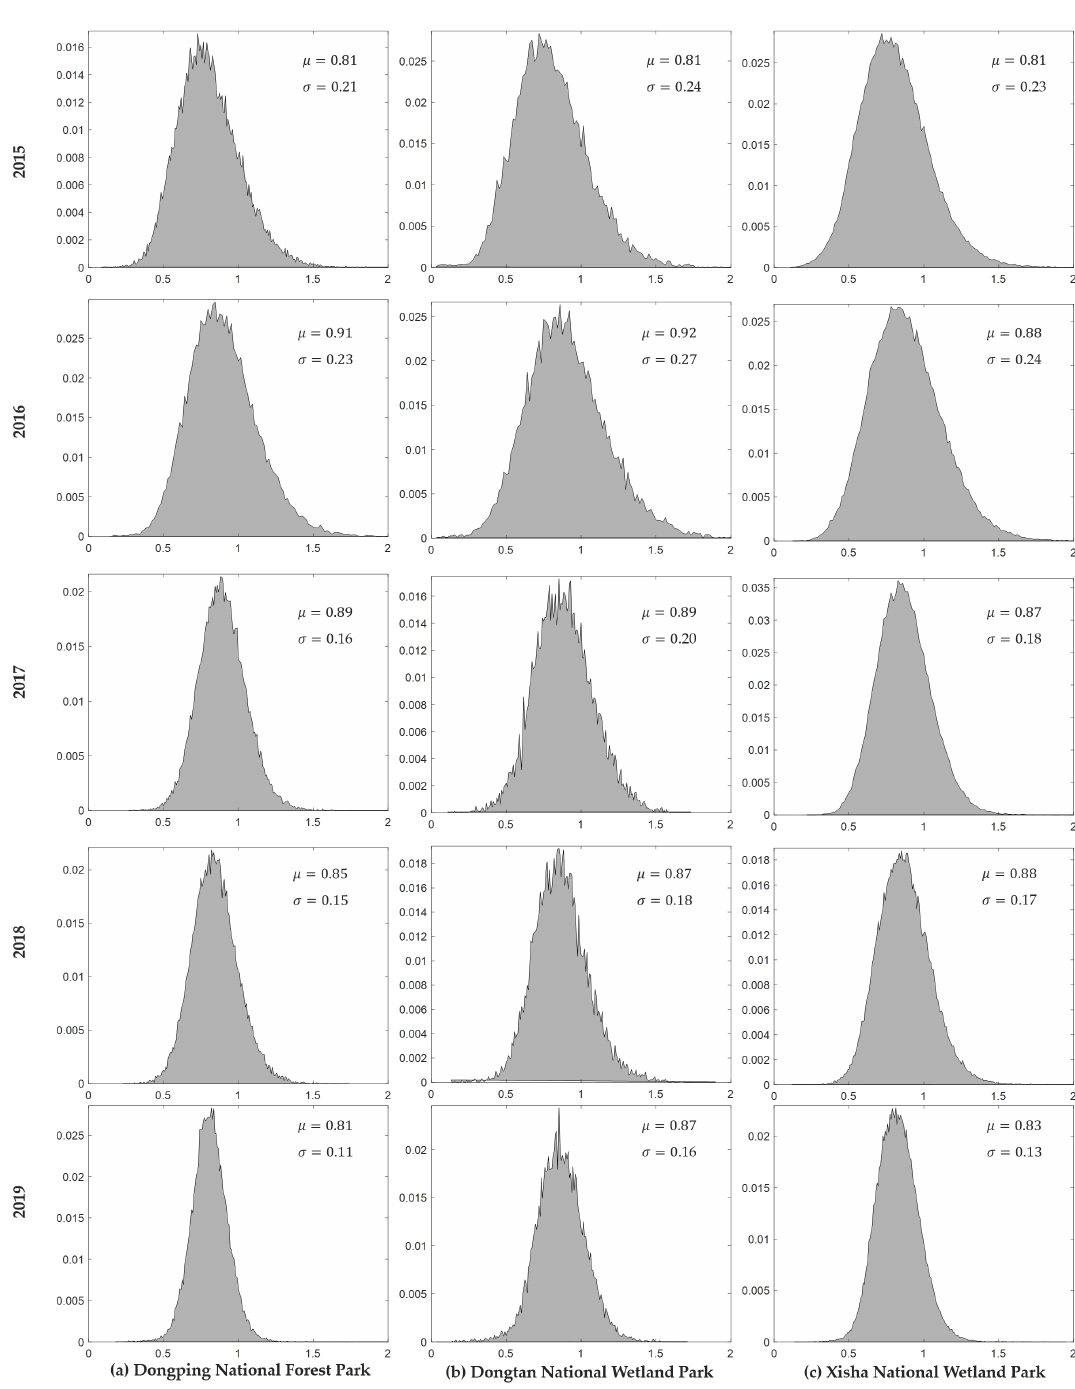
Figure 9. This figure shows the distribution of the radar vegetation index (RVI) on the different study sites with statistical parameters. These sites are well known and strictly protected forest areas. The different distributions in the same study region indicate forest area